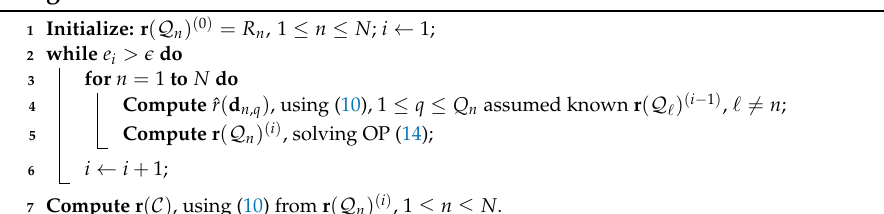
Algorithm 1: Iterative OP.